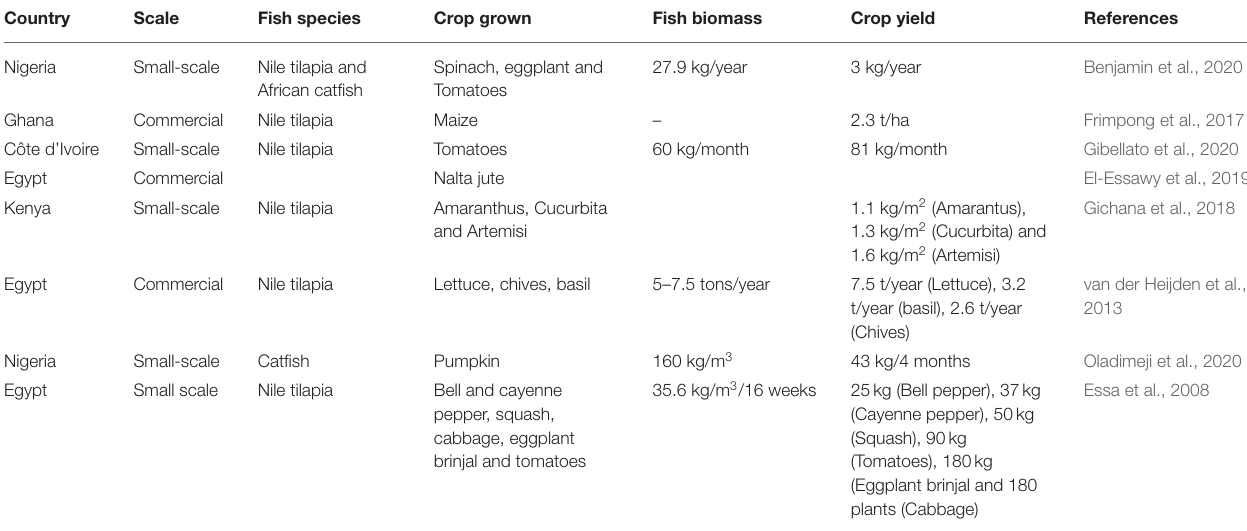
TABLE 1 | Fish and crop yields from aquaponics in Africa.